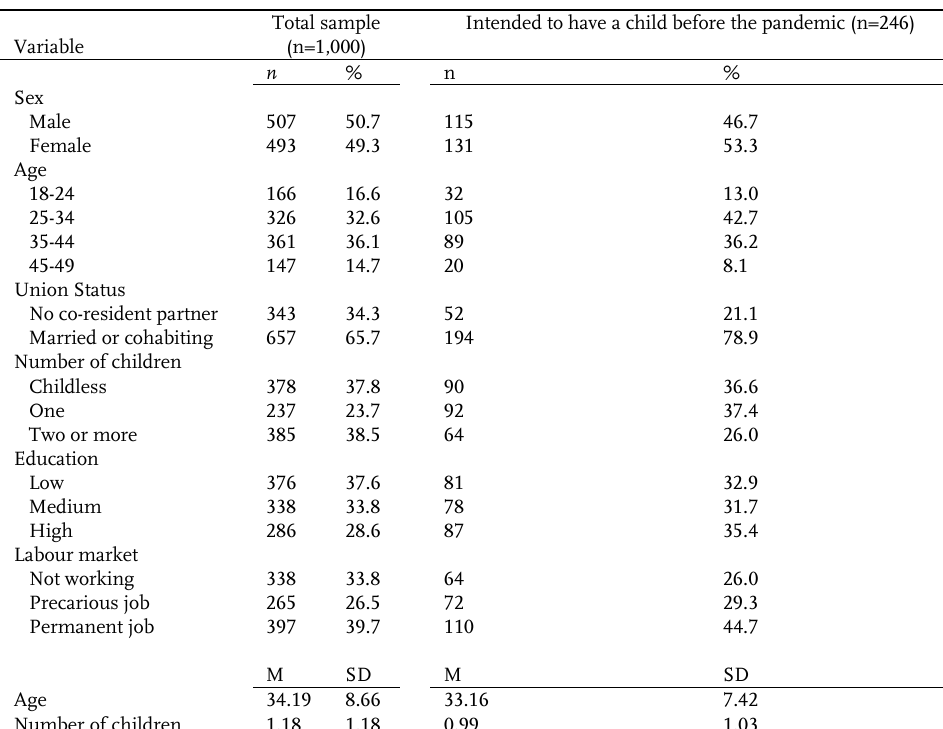
Table A.1 : The socio-demographic characteristics of the total sample (n=1000) and the analytic sample (n=246), divided by the declared impact of the pandemic on the respondents’ intention to have